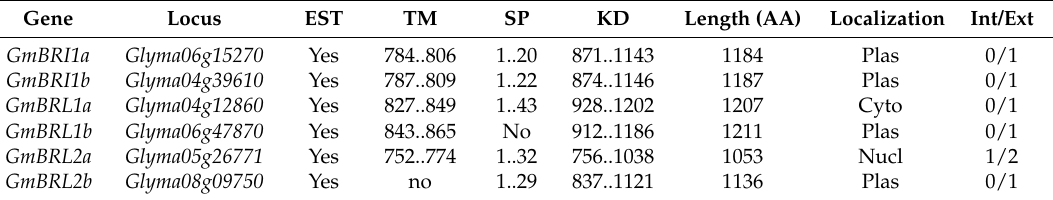
Table 1. General information about the brassinosteroid (BR) receptor genes in soybean based on bioinformatics